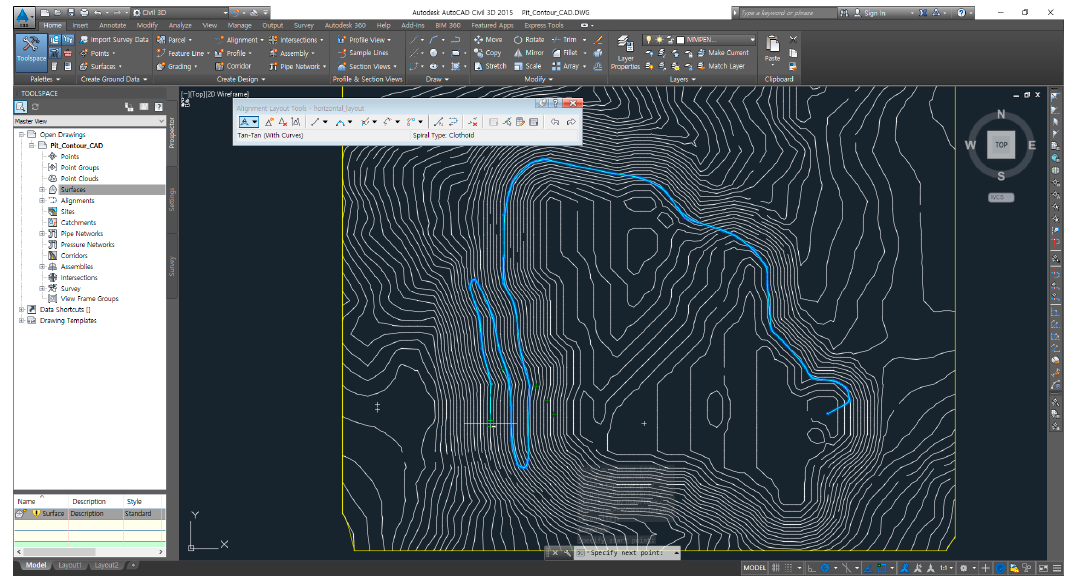
Figure 1. Example of haul road design for an open-pit mine using AutoCAD Civil 3D